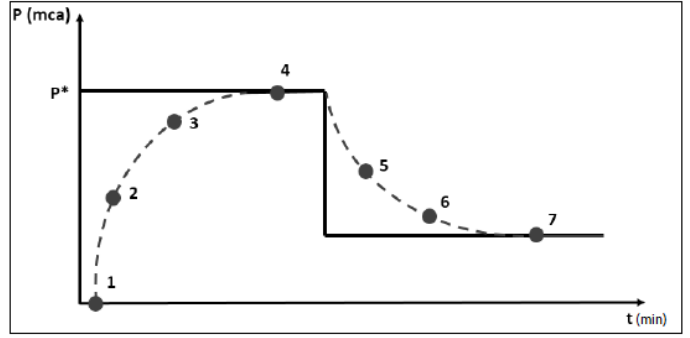
Figure 20. Desired behavior of the fuzzy control. Source: [32], adapted.